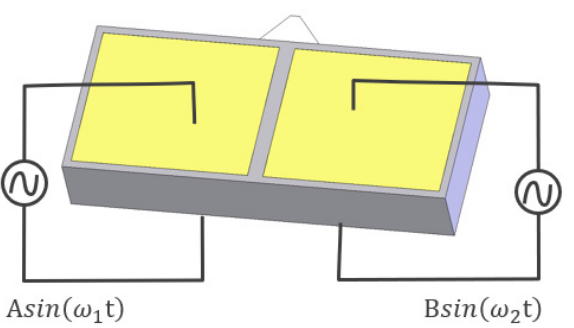
Figure 4. Dual-source-dual-frequency (DSDF) driving of the stator. Both electrodes on the piezoelectric plate are exposed to sinusoidal voltage signals at different frequencies ( ω 1 and ω 2 ) and different magnitudes (A and B).